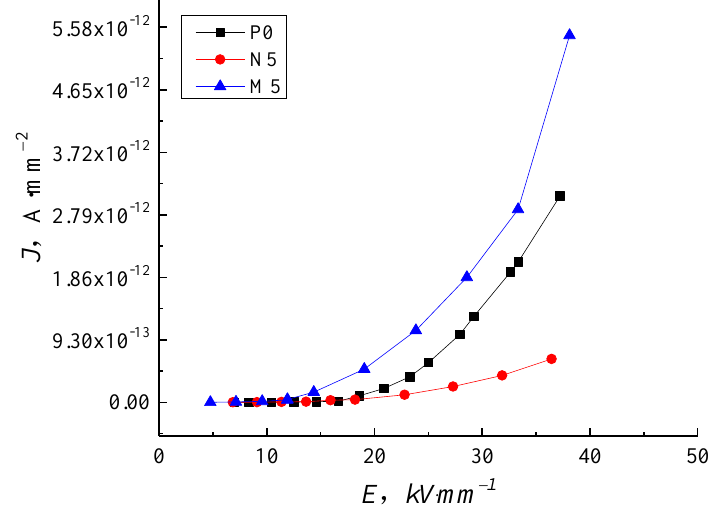
Figure 7. J-E characteristic curve of LDPE, nano-ZnO/LDPE and micro-ZnO/LDPE.